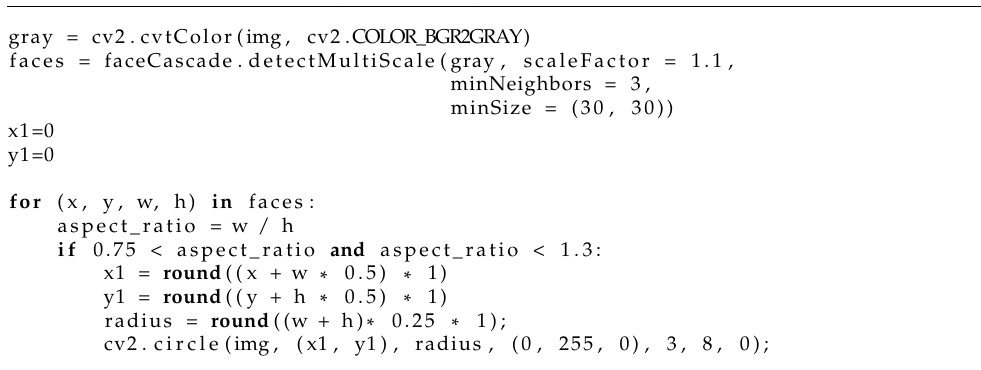
Algorithm 5 Face detection algorithm in Python.